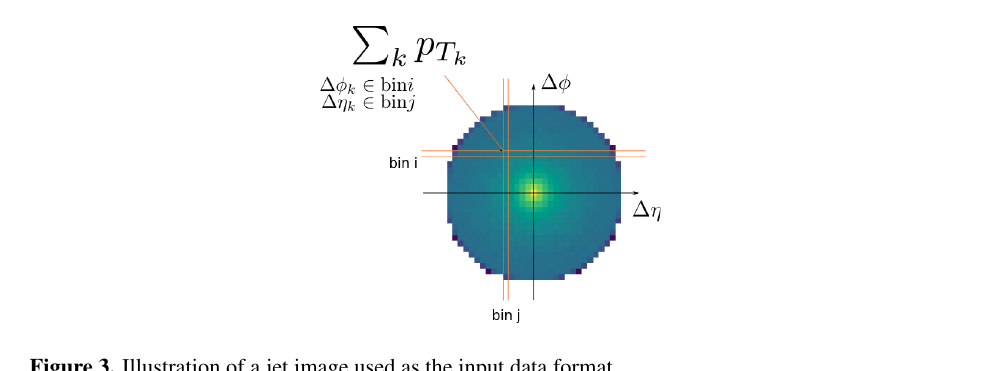
Figure 3. Illustration of a jet image used as the input data